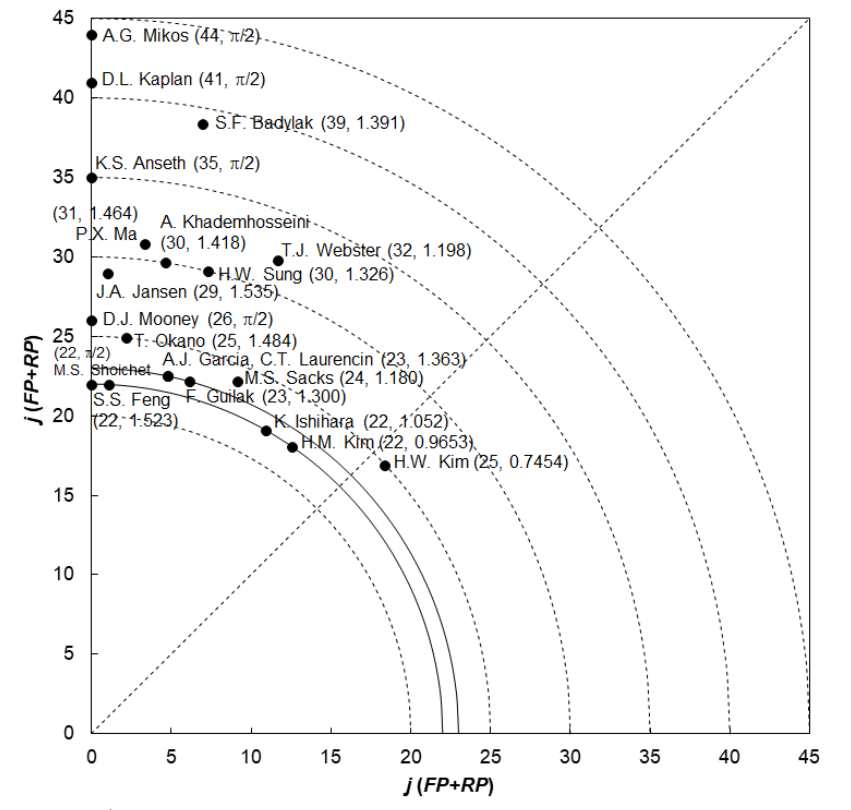
Fig. 2. Distribution of the top 20 highly cited authors with their Y -index values ( j ≥